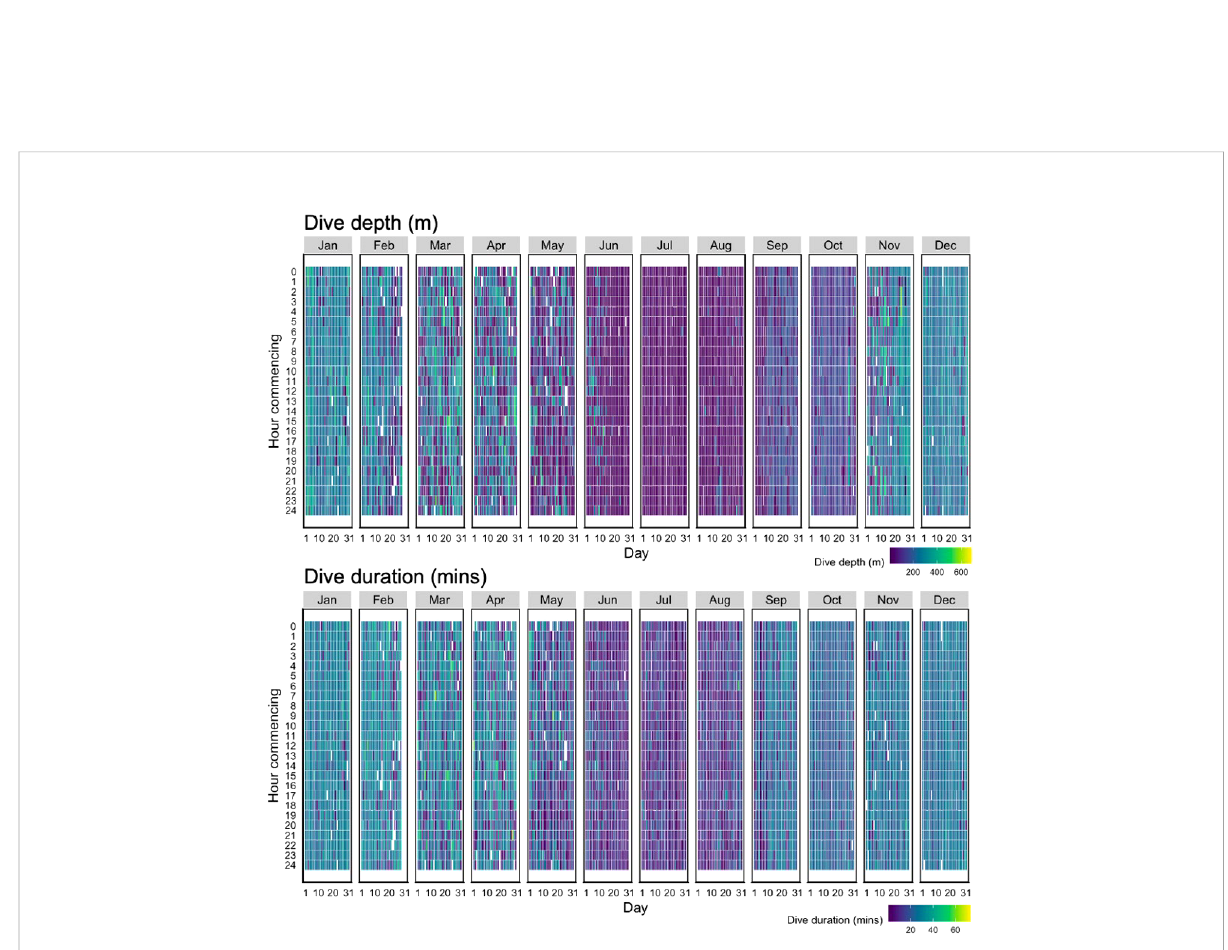
FIGURE 4 Heatmap of the maximum dive depth (m) (top) and minimum dive duration (mins) (bottom) of square-shaped dives (n=99,780) associated with resident behaviour for all bowhead whales (n=25) by time of day (Hour commencing) and day of the month (Day). Data are pooled across years (2012-2015) and include dives throughout their range (both inside and outside regions of